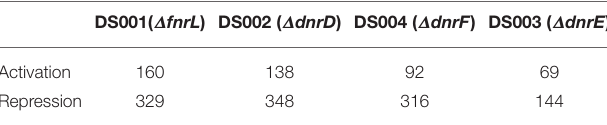
TABLE 4 | Comparative analysis of transcriptome results from fnrL and various dnr genes mutant strains under anaerobic conditions.